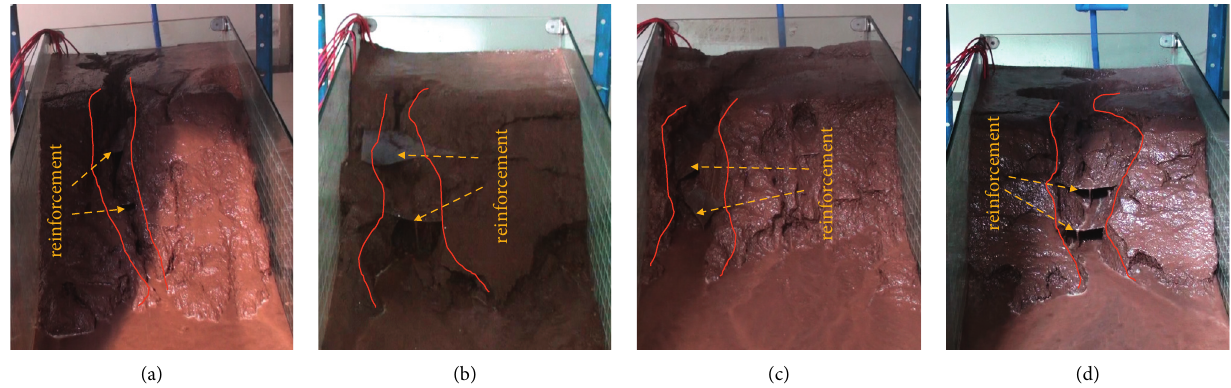
Figure 7: Final erosion failure of reinforced embankment with different slope gradients: (a) 30 ° ; (b) 35 ° ; (c) 40 ° ; (d) 45 °